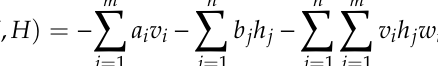
ff ect prediction based on